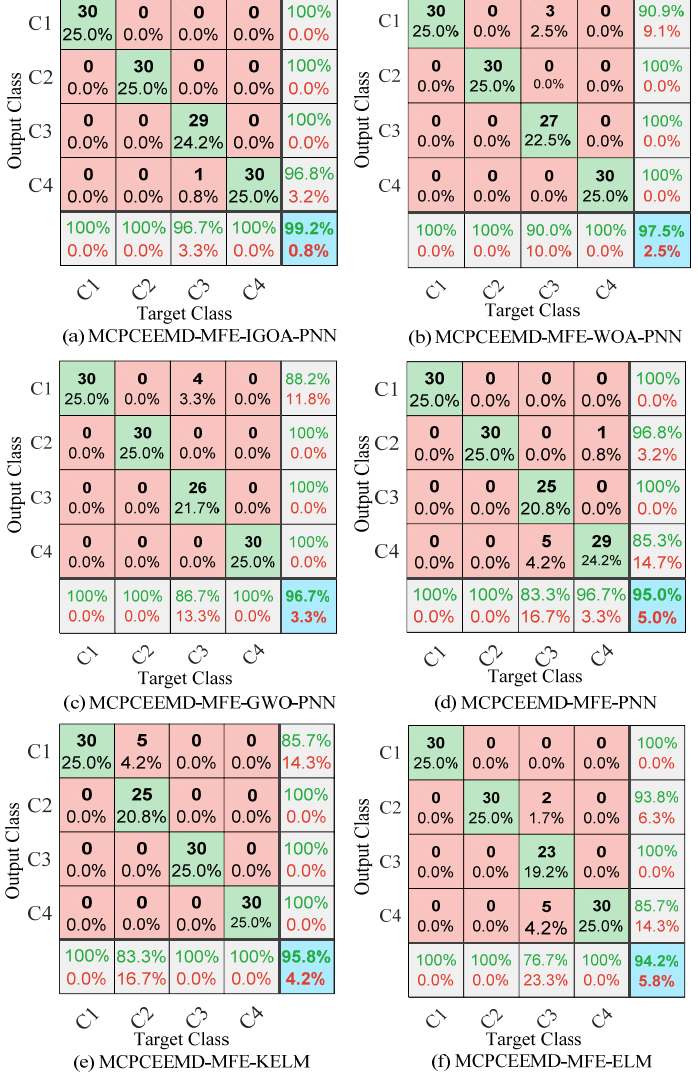
Figure 21. HVSR mechanical fault identification results.